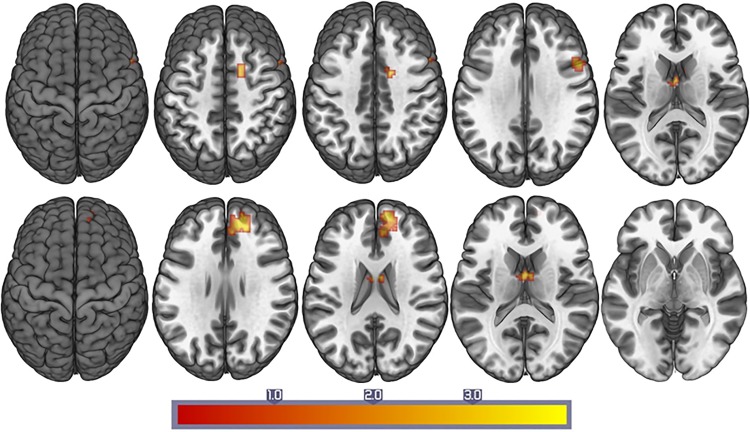
The differences of resting connectivity between HAND group and nonHAND group.Upper images display the regions showing the FC with the left precuneus (P < .05, corrected). Lower images display the regions showing the FC with the right precuneus (P < .05, corrected).